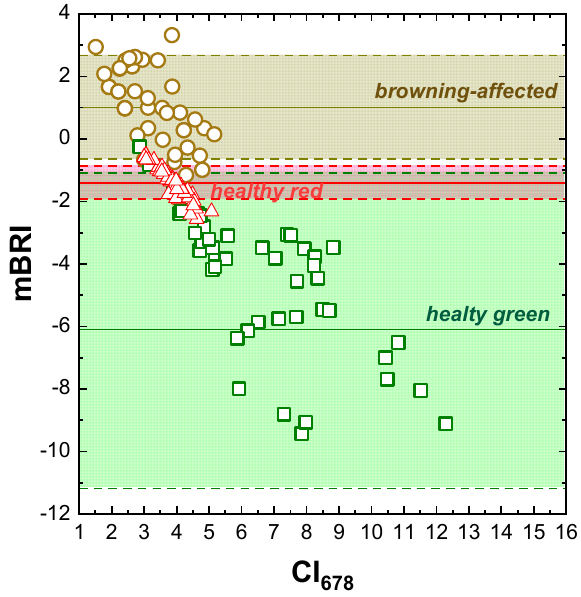
Figure 4. Comparison of the values of mBRI index calculated on the basis of hyperspectral reflectance images captured by the IH for healthy green (squares; –6.09 ± 5.00, n = 43), healthy red (triangles, –1.41 ± 0.52, n = 50), and those affected by scab- and scald-induced browning (circles; 1.00 ± 1.66, n = 50) apple fruits plotted vs. CI 678 —the ratio R 800 / R 678 , a proxy of Chl [12] . The average values ± STD are represented on the plot as solid and dashed horizontal lines, respectively. All the averages were significantly different according to the Student’s t -test at the level of p < 0.05. The corresponding raw spectra can be found in the supplementary data file; see also Figure S3.